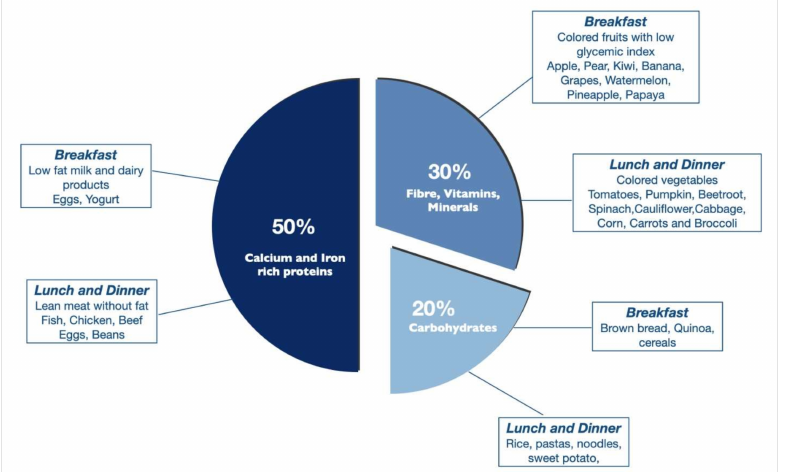
Figure 5. Example of the bariatric plate model based on macronutrient composition with breakfast and lunch